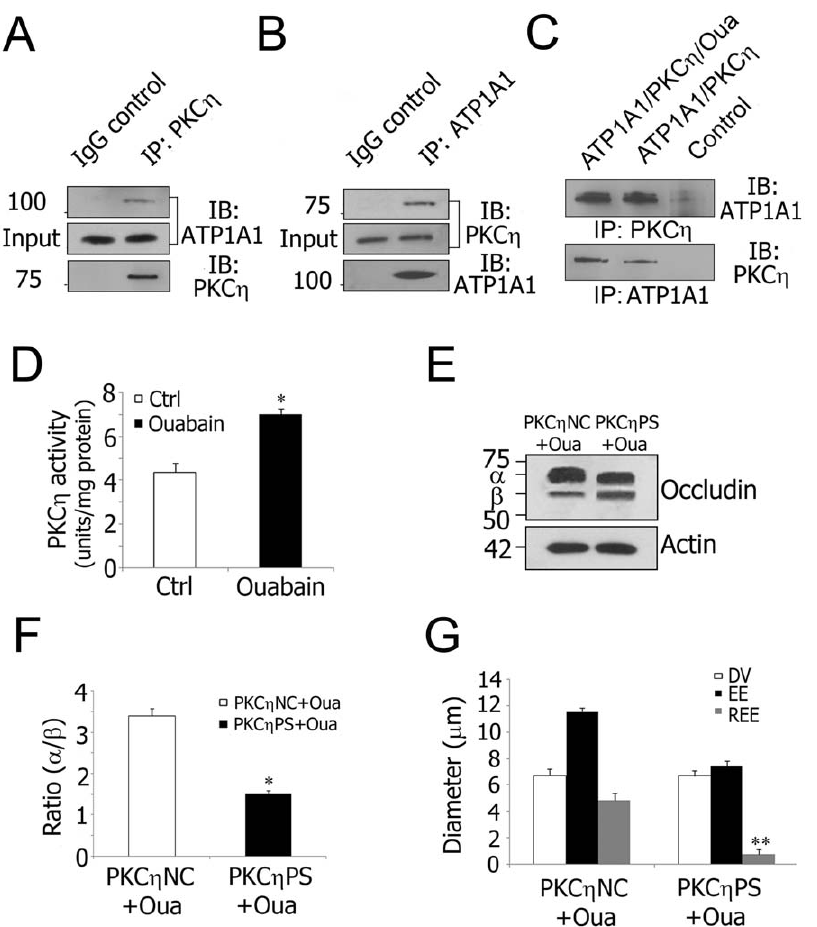
Figure 5. Decreased Na + /K + -ATPase activity increases TJ permeability via PKC g phosphorylated occludin. A and B , Co- immunoprecipitation using isolated stria vascularis capillary lysates shows that PKC g is in a complex with ATP1A1. Goat IgG served as a negative control. C , Protein-protein interaction analysis with purified ATP1A1 (250 ng) and PKC g (250 ng). Ouabain (10 m M) was added where indicated. Control lanes consisted of either anti-ATP1A1 antibody and purified PKC g or anti-PKC g antibody and purified ATP1A1. D , Ouabain inhibition of Na + / K + -ATPase activity causes increased PKC g activity in isolated stria vascularis capillaries (*P=0.013 , 0.05). E and F , PKC g PS pretreatment significantly attenuated ouabain-induced occludin hyperphosphorylation compared to pretreatment with PKC g NC (* P=0.011 , 0.05). G , REE analysis shows a significant attenuation in ouabain-induced permeability in PKC g PS pre-treated tissues (**P=0.005 , 0.01). REE, relative extension of serum protein IgG extravasation; DV, diameter of the vessels; EE, extension of IgG extravasation. Values in D , F and G are mean 6 SEM